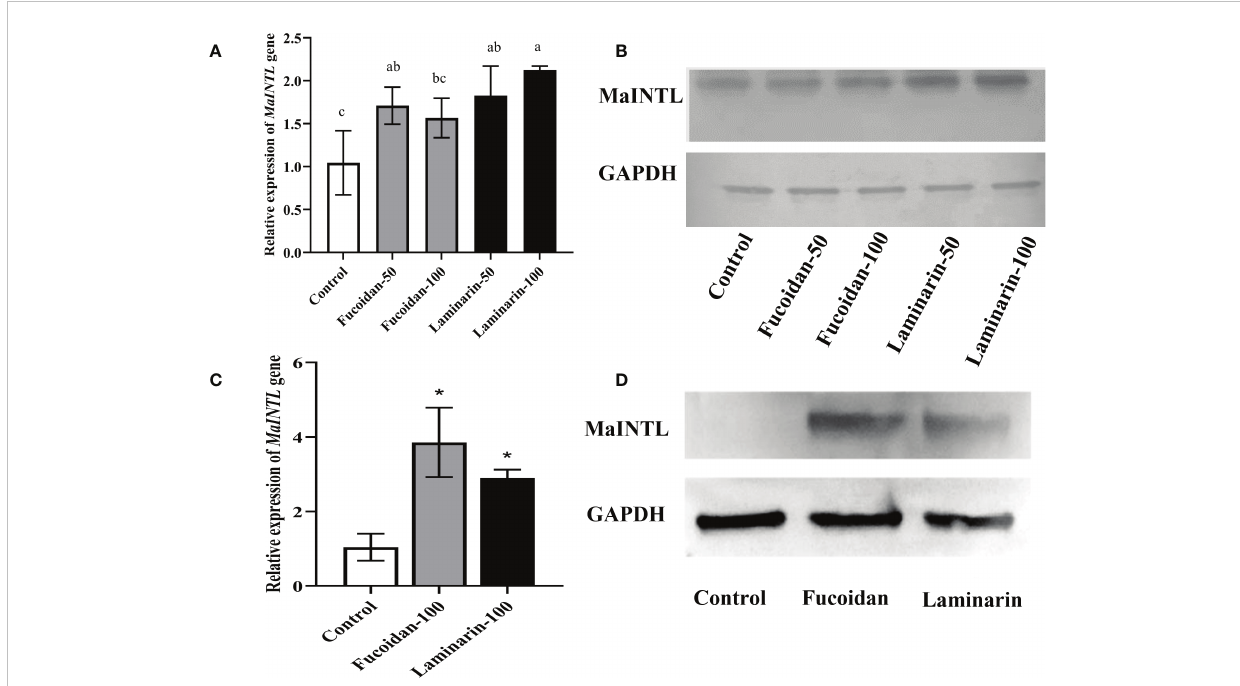
FIGURE 3 Induction of MaINTL expression by fucoidan and laminarin in macrophages and hepatocytes. (A) Induced expression of MaINTL by fucoidan and laminarin in hepatocytes detected by RT-qPCR, asterisks indicated notably statistical difference ( P < 0.05 ). (B) Western blotting was performed to detect the induction of MaINTL expression by fucoidan and laminarin in hepatocytes. (C) Induced expression of MaINTL by fucoidan and laminarin in macrophages detected by RT-qPCR, asterisks indicated notably statistical difference ( P < 0.05). (D) Western blotting was performed to detect the induction of MaINTL expression by fucoidan and laminarin in macrophages.